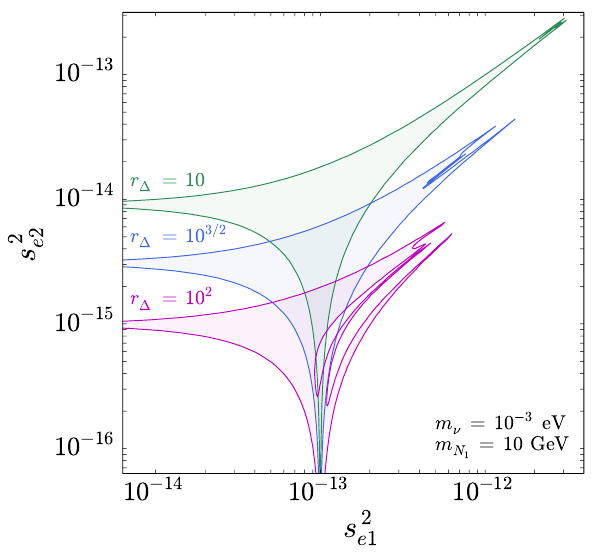
Figure 5 . Modi(cid:12)ed allowed regions for the active-sterile mixing strengths satisfying the tree- level constraint ( ) 11 = 0 and the condition for the one-loop contribution to be M (cid:23)